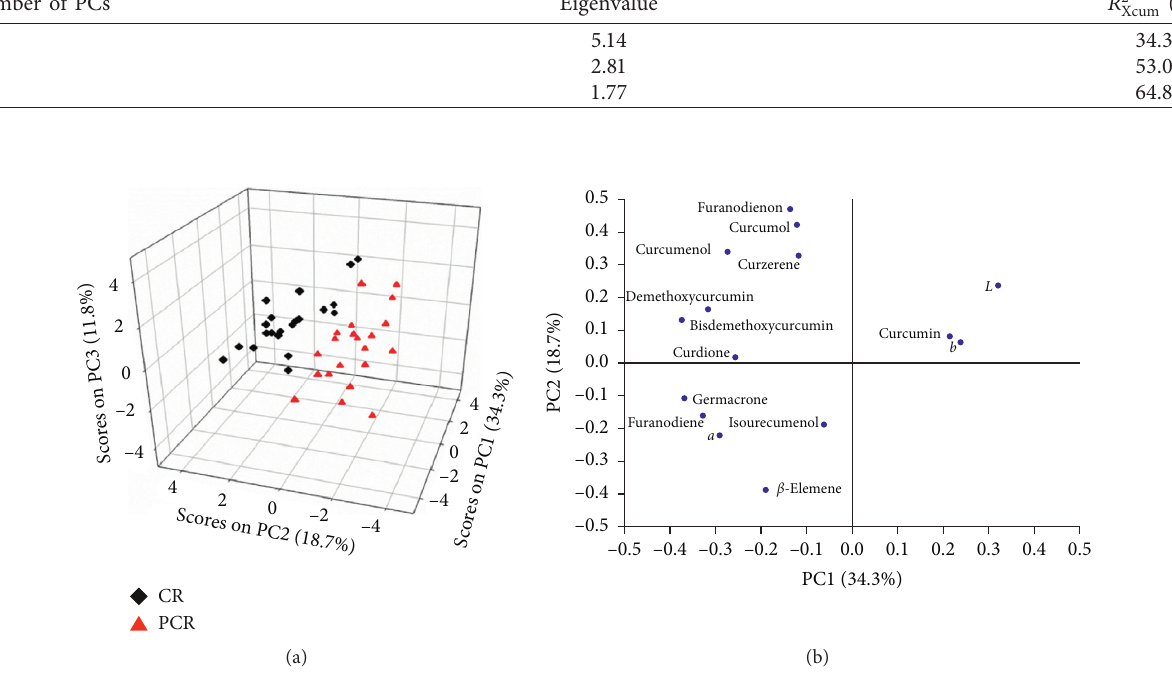
Figure 6: PCA model constructed on the data that combined the chemical ingredients and colours for differently prepared slices of Zedoray Rhizome samples. (a) Score plot. (b) Loading plot. Table 5: The Pearson correlation analysis of the colour parameters and the chemical ingredients. Chemical